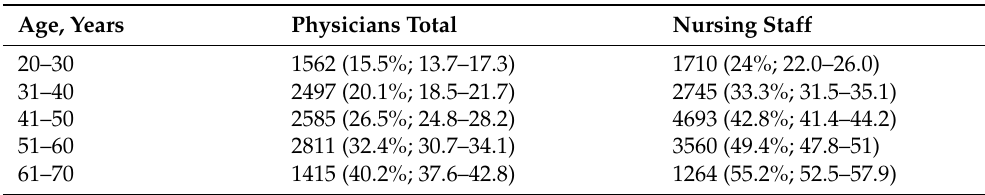
Table A6. Question: “Are you ready to recommend vaccination against COVID-19?” depending on the age of physicians and nursing